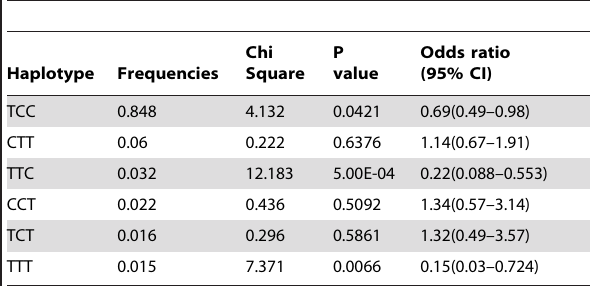
Table 4. The haplotype association of gpx1 with KBD in this